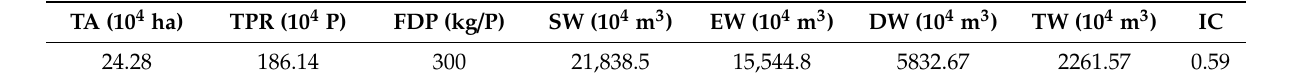
Table 2. The basic model